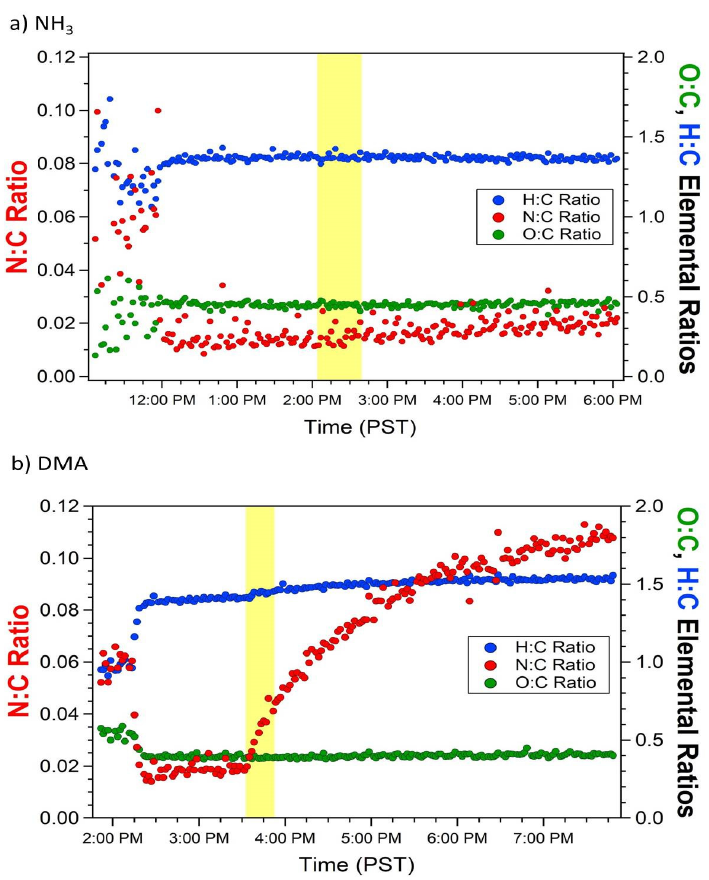
Figure 2. Elemental ratios of LIM/O 3 SOA particles when exposed to ( a ) NH 3 and ( b ) DMA at low relative humidity (yellow shaded